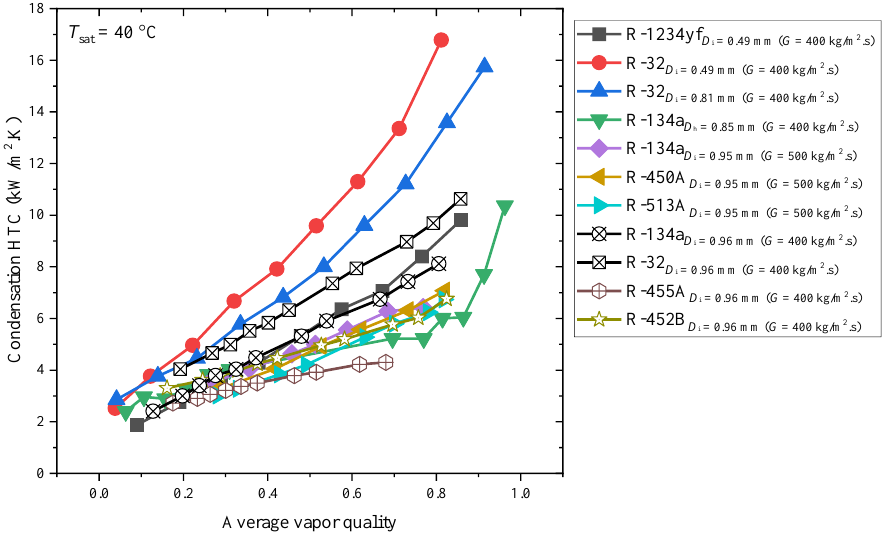
Figure 11. Condensation HTCs of various refrigerants inside the minichannel. Rectangular, circular, and triangular upward solid connected line presents the Jige et al. [42] study, triangular downward solid connected lines present the Jige et al. [43] study, star, triangular backward and forward solid connected line presents the Morrow and Derby [45] study, circular cross and rectangular cross solid connected line presents the Matkovic et al. [47] study, and remaining symbols (circular plus and star) solid connected lines presents the Azzolin et al. [51] study.